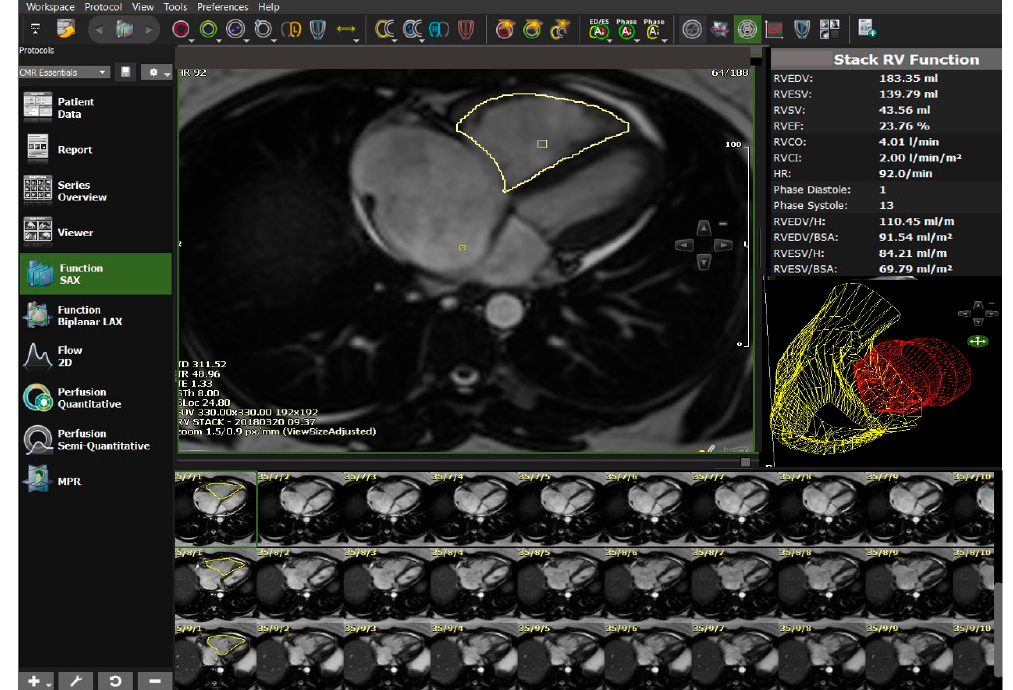
Figure 10. Automated right ventricular quantitative analysis and display from cvi42 MR-Circle Cardiovascular Imaging Viewer software. In this 37-year-old female with idiopathic pulmonary arterial hypertension, there is significant impairment of RV systolic function with RV ejection fraction of 24%. Automatic contour detection based on deep learning algorithms allows for a reduction in contouring times to seconds and has been shown to have an accuracy equivalent to human performance with consistent reproducibility. Diagnostics 2020 , 10 , x FOR PEER REVIEW